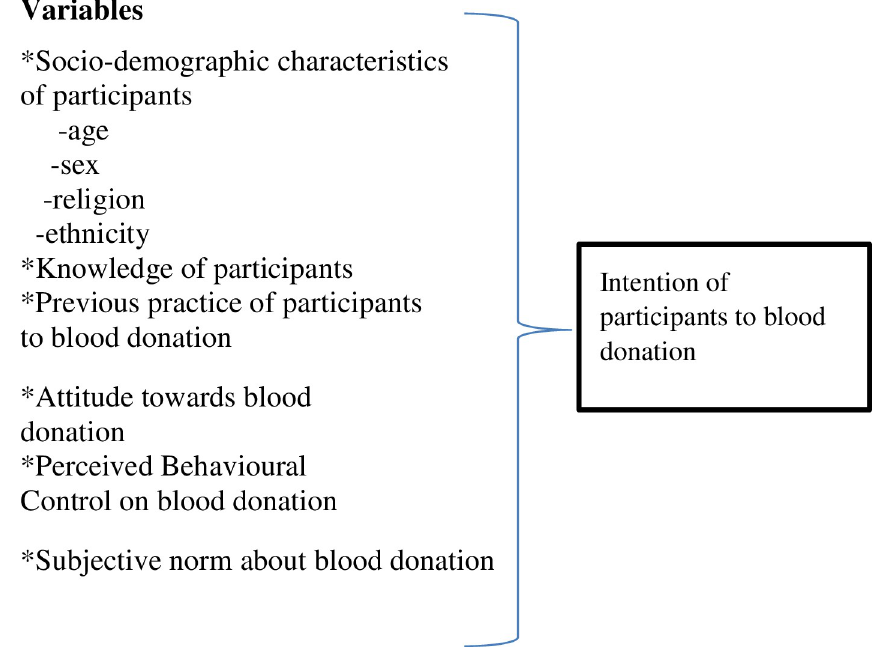
Fig 1. Showing dependent and independent